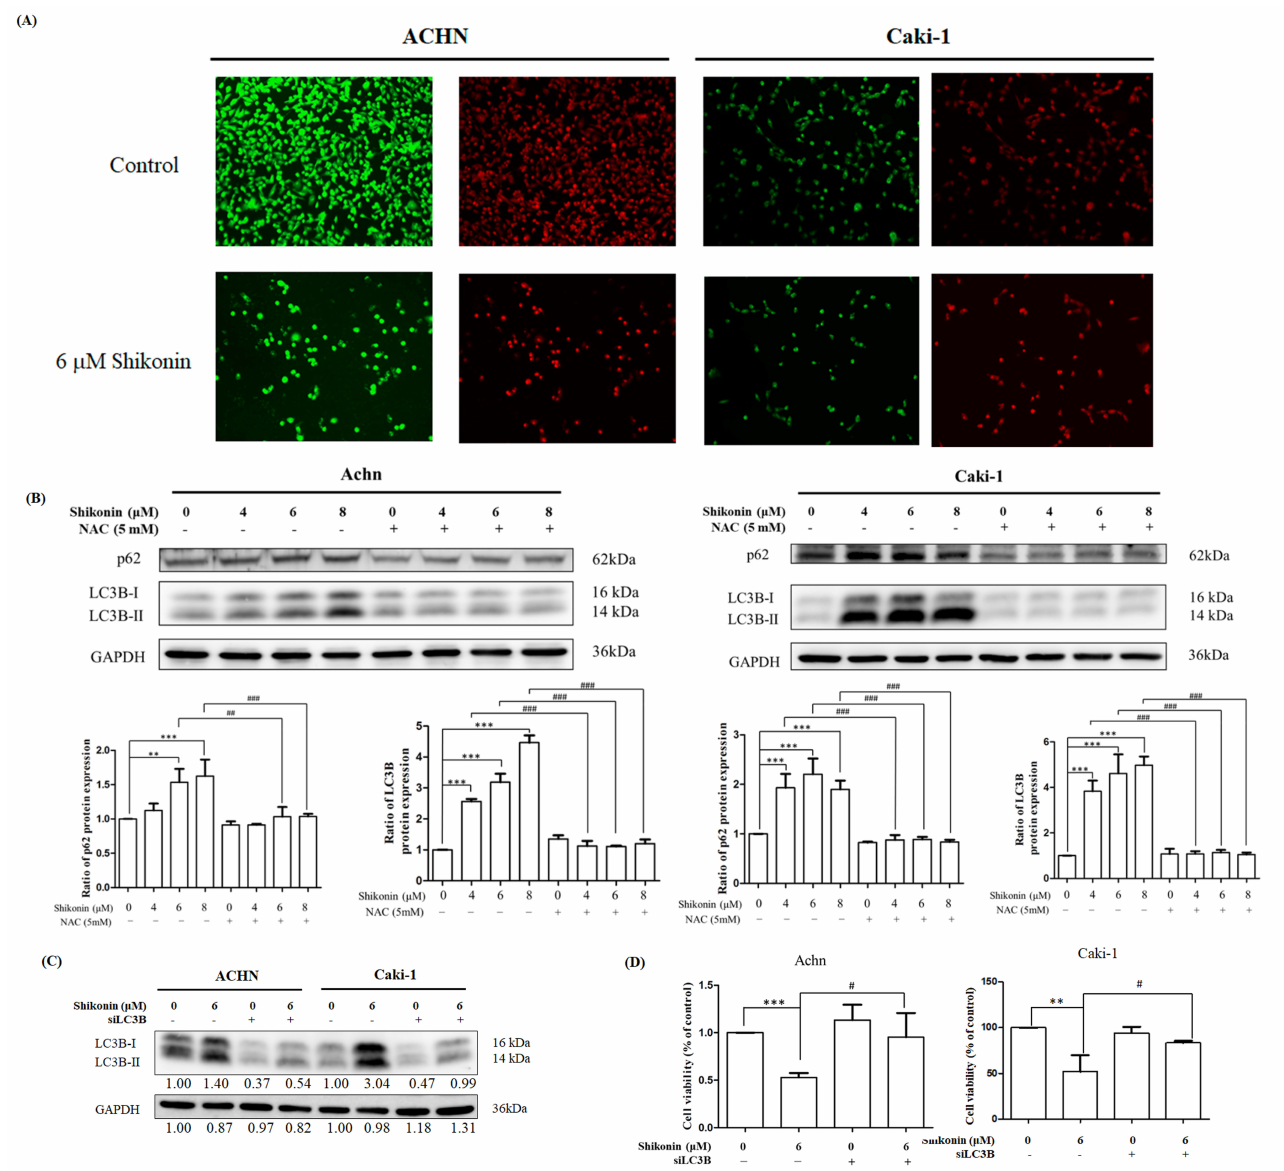
Figure 7. Shikonin induced autophagy in RCC cells. ( A ) ACHN (right panel) and Caki-1 (left panel) cells were treated with 0 or 6 µ M shikonin for 24 h and subjected to acridine orange staining and the images were captured under a fluorescence microscope. ( B ) ACHN and Caki-1 cells were treated with 0, 4, 6, and 8 µ M shikonin with or without NAC pretreatment. The cell lysates were analyzed by Western blot using LC3B and p62 antibodies. GAPDH was used as the loading control. Data represent means ± standard deviation from at least three independent experiences. ** p < 0.01 and *** p < 0.001 compared with the control group. # p < 0.05, ## p < 0.01 and ### p < 0.001 compared with the NAC pretreated group. GAPDH was used as the internal control. ( C ) ACHN and Caki-1 cells were treated with 6 µ M shikonin in the presence or absence of LC3B-II siRNA (siLC3B) for 24 h. The cell lysates were analyzed by Western blot using LC3B antibody. ( D ) ACHN and Caki-1 cells were treated with 6 µ M shikonin in the presence or absence of siLC3B for 24 h. Cell viability was measured by MTT assay. Data represent means ± standard deviation from at least three independent experiences. ** p < 0.01 and *** p < 0.001 compared with the control group. # p < 0.05 compared with the siLC3B